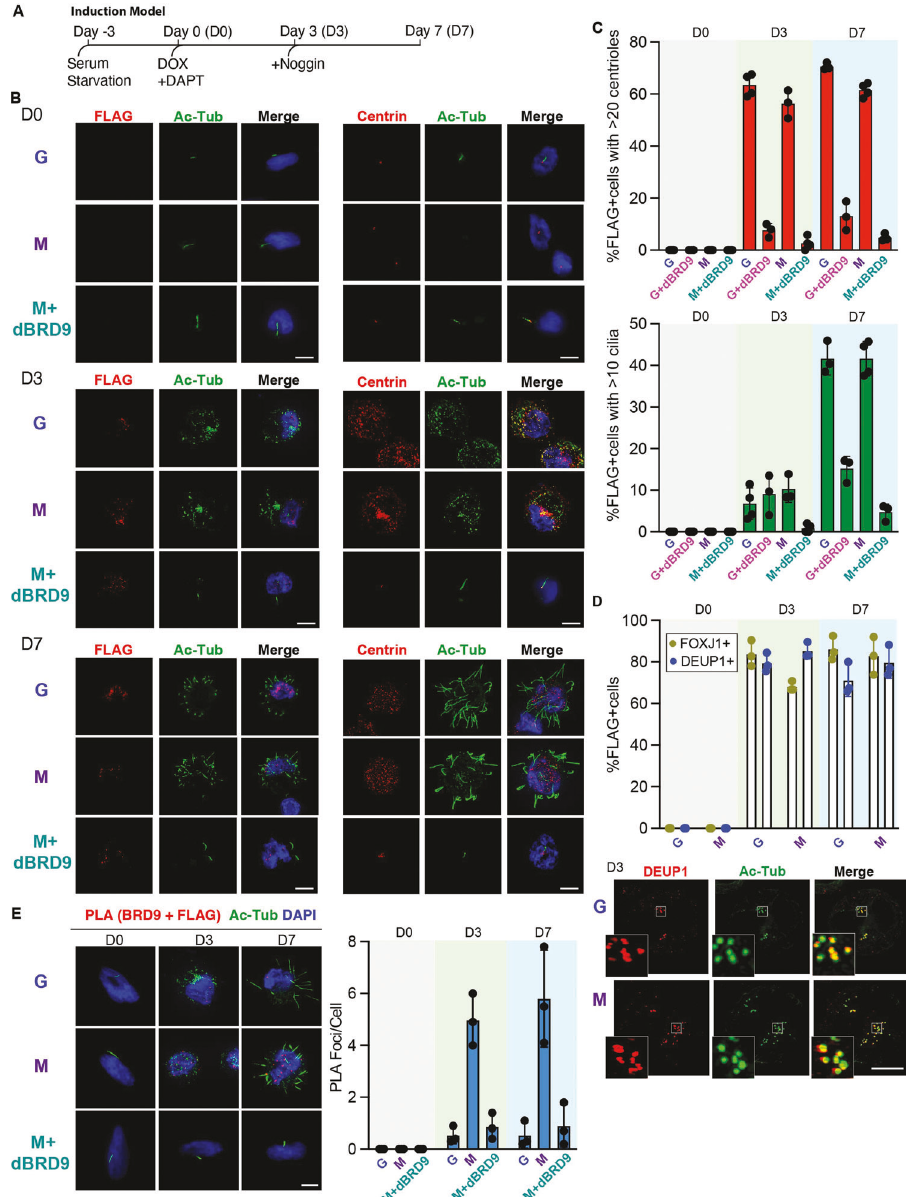
Fig. 5 BRD9 depletion inhibits multiciliogenesis in a cell line model. A Schematic demonstrating the time course of the inducible system used to generate MCCs in human DBTRG-05MG cells. For full details, see methods section. B Immuno fl uorescence using the indicated markers in cells expressing either G = pSLIK-FLAG-BirA*-GEMC1, M = pSLIK-FLAG-BirA*-MCIDAS or M + dBRD9 = pSLIK-FLAG-BirA*-MCIDAS + dBRD9 (20 μ M). Images are taken at three different time points: Day 0, Day 3, and Day 7. Scale bar = 10 μ M. C Quanti fi cation of Immuno fl uorescence shown in B . Centriole and cilia counts were generated in FLAG positive cells, using Centrin and acetylated tubulin (Ac-Tub) as markers. N = 3 or 4 independent experiments with a total of 150 – 200 cells scored. Averages of each experiment are shown (ovals) with mean (vertical bars) and standard deviation. D Quanti fi cation of FOXJ1 or DEUP1 positive cells in the FLAG positive population from 3D-SIM images. Example of Day 3 image for DEUP1 shown below. Additional images in Supplementary Figure S6A. Scale bar = 5 μ M. E Proximity ligation assays (PLA) counter stained with Ac-Tub and DAPI, corresponding to the indicated conditions in. Scale bar = 10 μ M. Quanti fi cation of PLA foci from n = 3 independent experiments are shown in adjacent right panel. 100 cells were scored per condition. activating the multiciliation program, as well as murine ALI MTEC ability to generate MCCs. Treatment with I-BRD9 reduced the cultures generating functional motile cilia. expression of both Foxj1 and Trp73 at the mRNA and protein level in a dose-dependent manner (Fig. 6A – C). In addition, there was a dose- dependent reduction in cells exhibiting centriole ampli fi cation DISCUSSION (inferred by staining for Centrin and Deup1) (Figs. 6A, D, E) and MCCs have an intriguing developmental program in which post- multiciliogenesis (inferred by staining with Acetylated tubulin mitotic MCC precursors support the explosive generation of antibodies (Ac-tubulin) (Fig. 6A, F). Together these data indicated numerous centrioles that mature into basal bodies for that ncBAF function is essential for multiciliogenesis in human cells